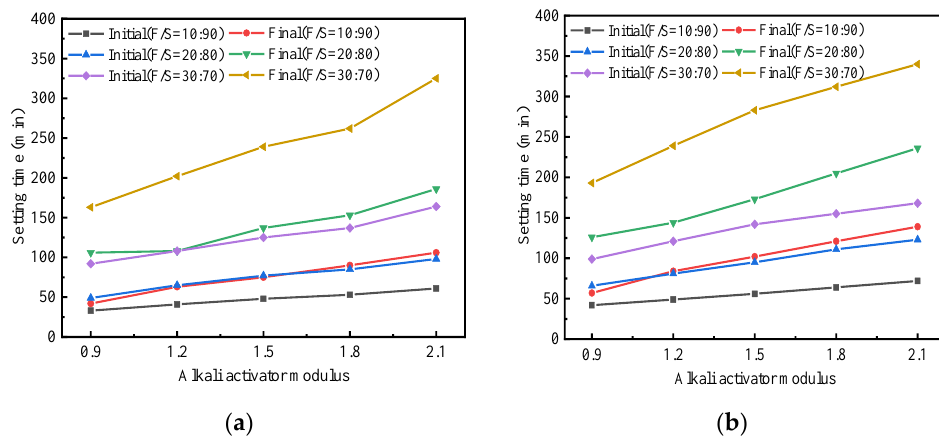
Figure 2. Setting time of stabilized soil: ( a ) One-step method. ( b ) Two-step